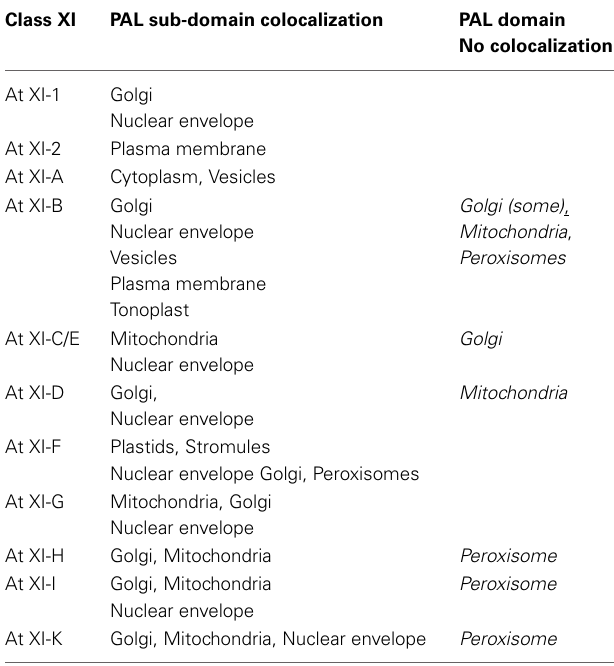
Table 1 | Summary of localization of PAL sub-domains of A. thaliana class XI myosins N-terminally fused to YFP and transiently expressed in leaves epidermal cells of N. benthamiana .